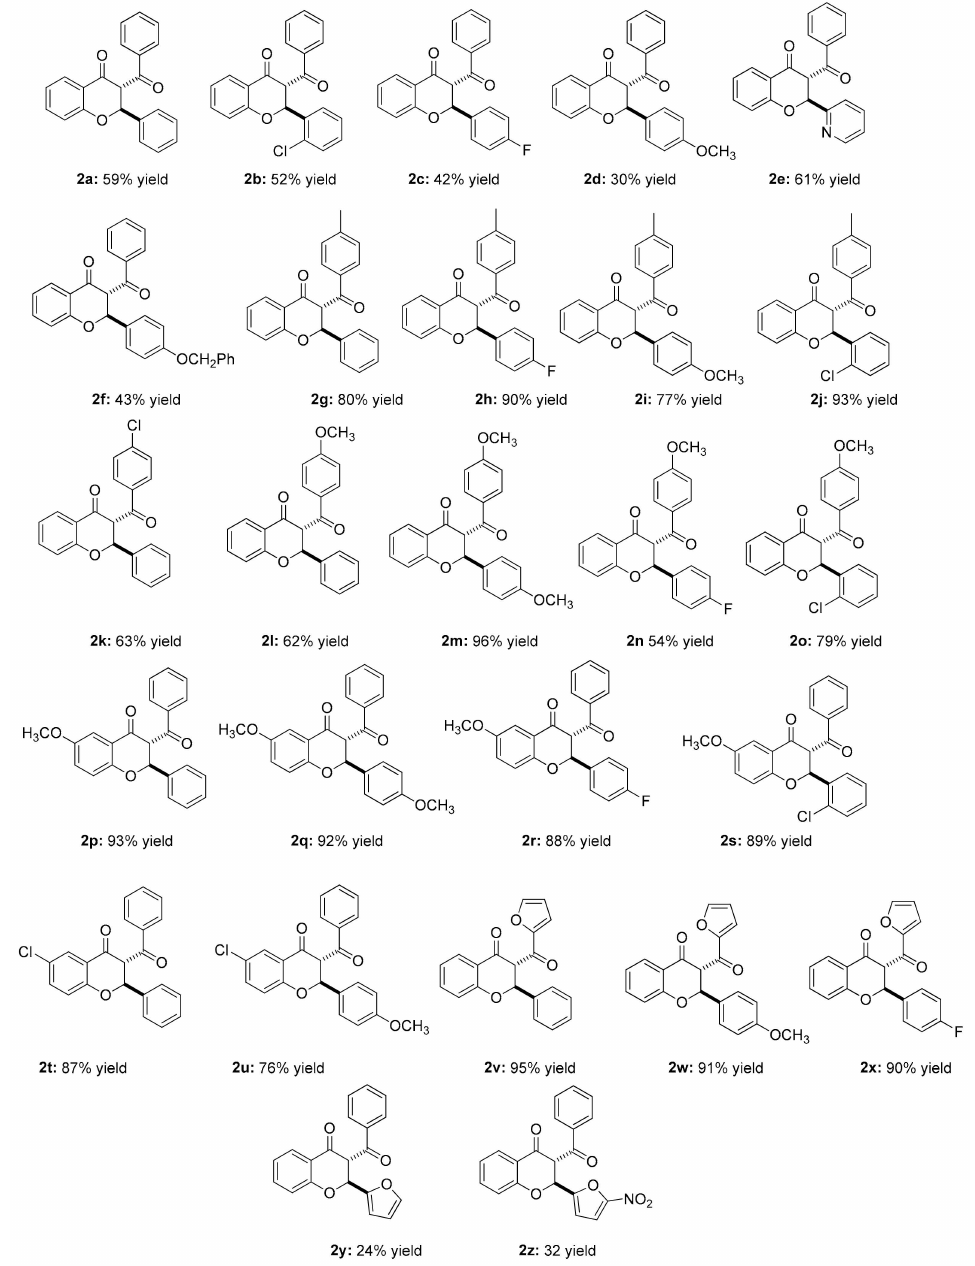
Figure 2. Synthesized 3-benzoyl-flavanones.